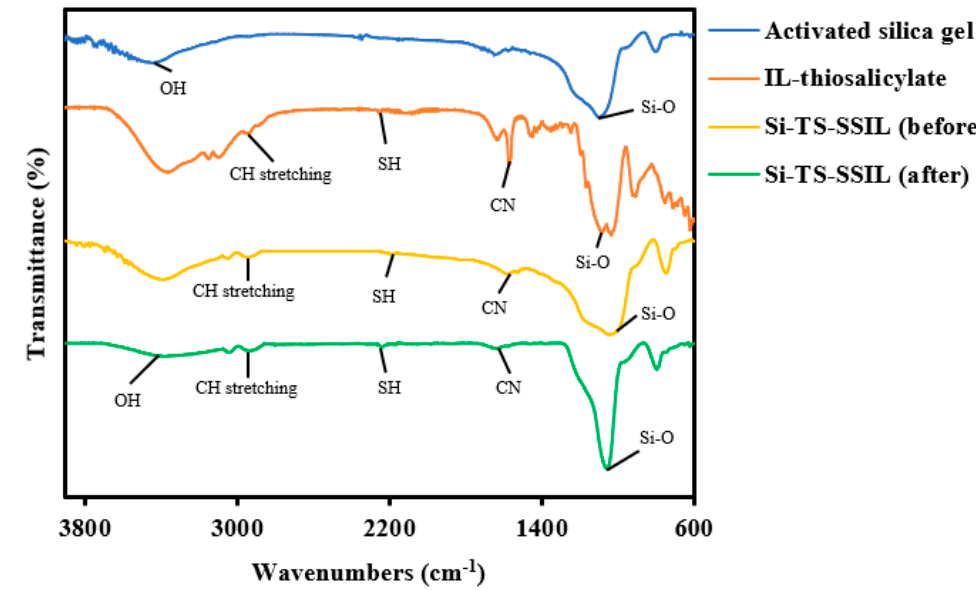
Figure 2. FTIR spectra of the newly synthesized 1-methyl-3-(3-trimethoxysilylpropyl) imidazolium thiosalicylate ([MTMSPI][TS]) ionic liquid, activated silica gel, and Si-TS-SSIL before and after the adsorption process.